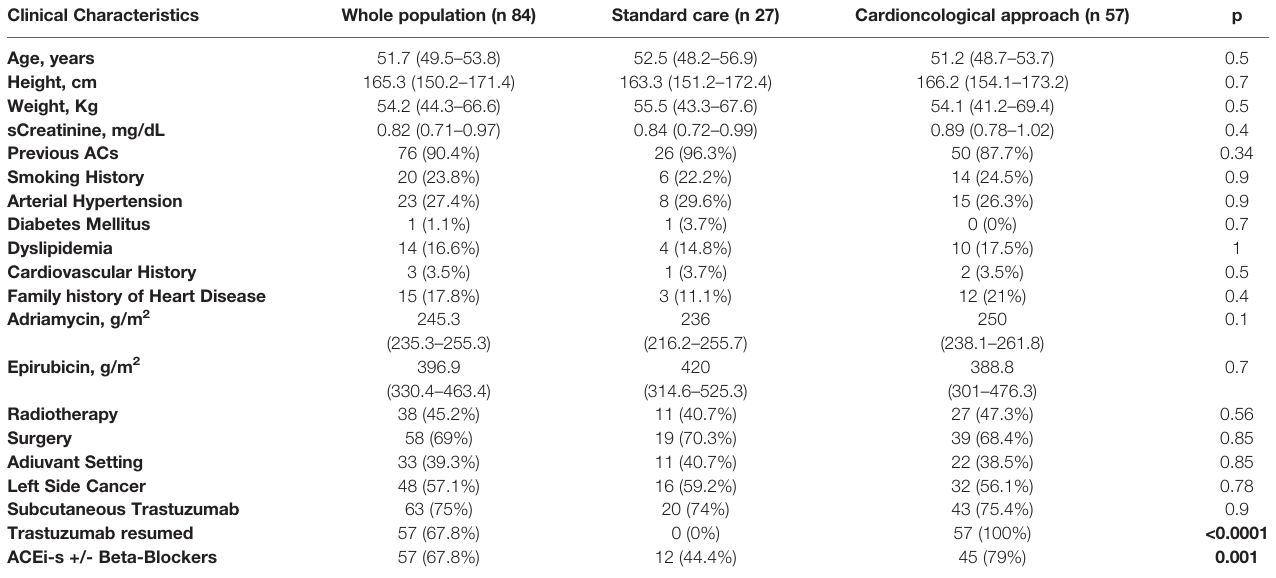
TABLE 1 | Population characteristics (n